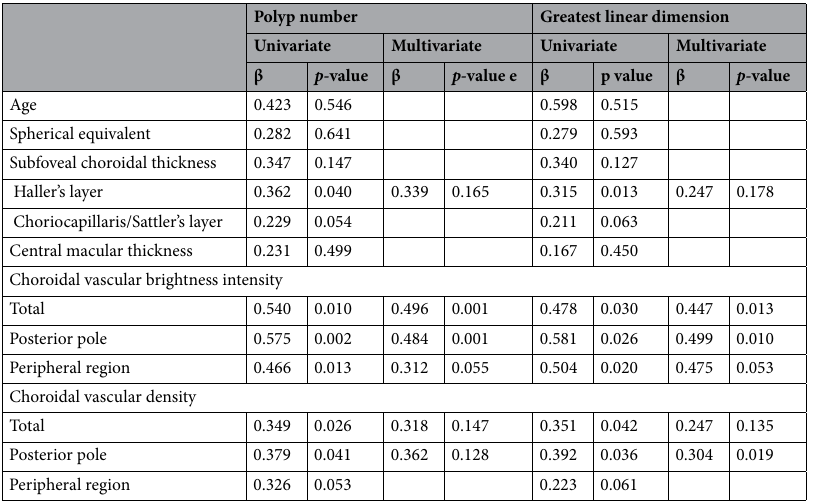
Table 6. Univariate and multivariate linear regression analysis of factors related to phenotypes of PCV. Multivariate model adjusting for factors significant in univariate analysis at p < 0.05. PCV polypoidal choroidal